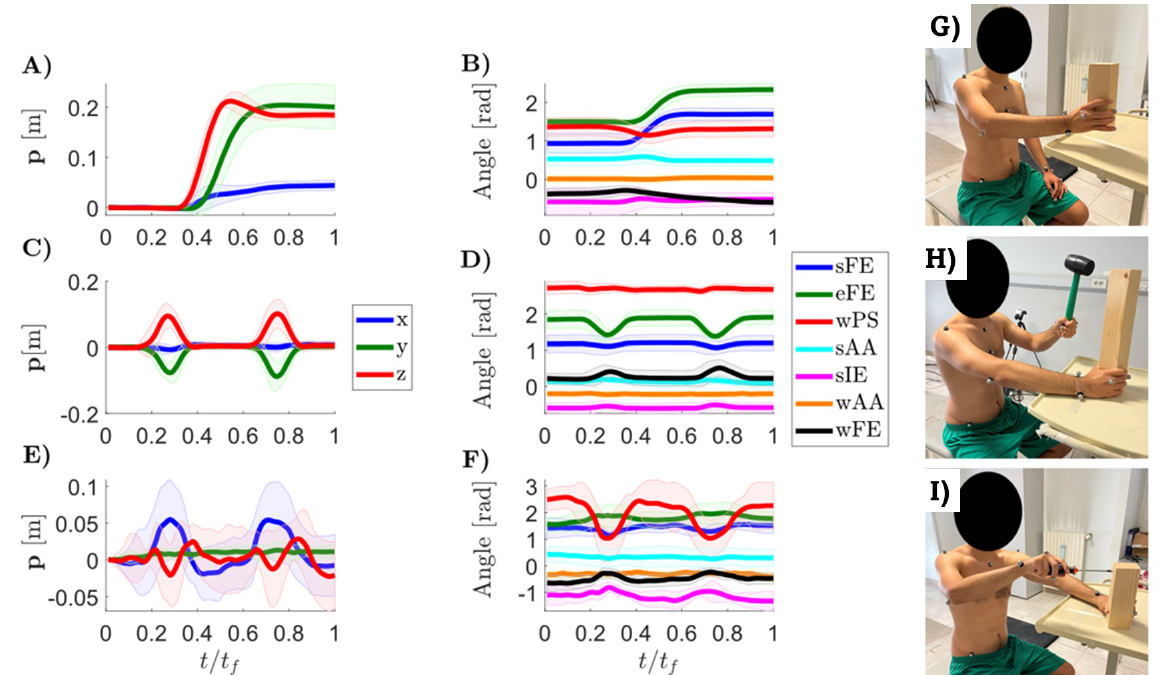
Figure 4. Mean (solid lines) and standard deviation (shaded area) of both Cartesian trajectories ( A , C , E ) and joints ( B , D , F ) of the WGD. The time ( t ) is normalized with respect to the time needed to complete the movement ( t f ). These plots were obtained by averaging all the collected trajectories of all the enrolled subjects for all the executed repetitions, retrieved at one specific target position. In particular, the ( A , B ) is referred to handling goods task, ( C , D ) to hammering and ( E , F ) to screwing. For both the hammering and screwing are reported two repetitions. Handling goods, hammering and screwing real working activity executions are reported in ( G – I ), respectively.